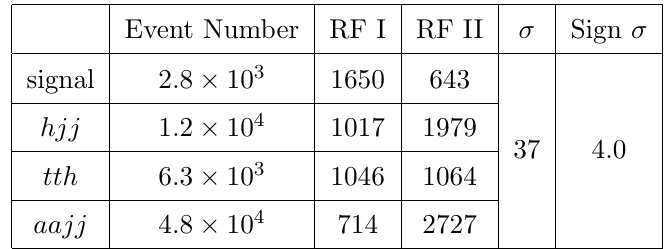
Table 9 . Same as table 5, but with a simpler RF with only 8 input